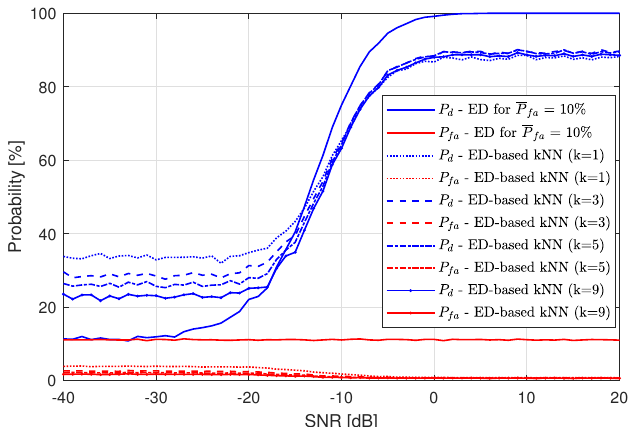
Figure 7. Resulting probability of detection P d and probability of false alarm P fa of the Energy Detection-based k-Nearest Neighbors method for ¯ P fa =